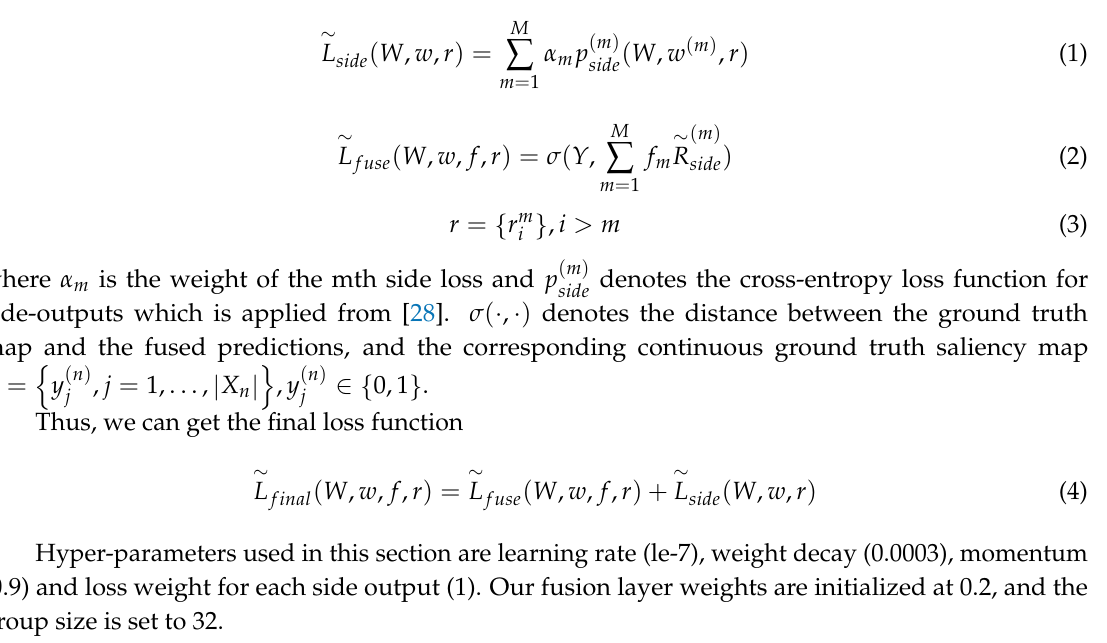
Figure 5. Skip layer short connections in network architecture.